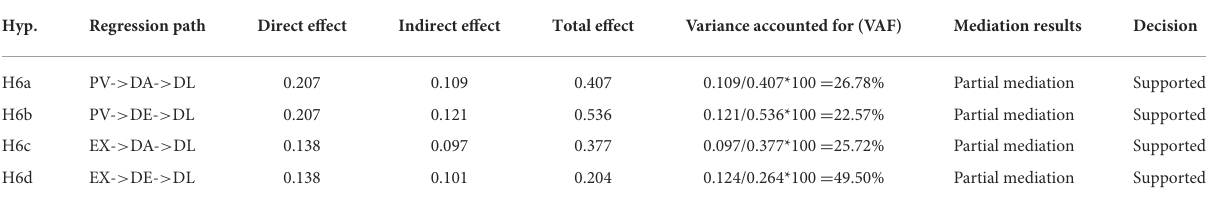
TABLE 5 Mediation analysis. Mediation outcome of perceived value and experience